Question: How would you classify this visualization?
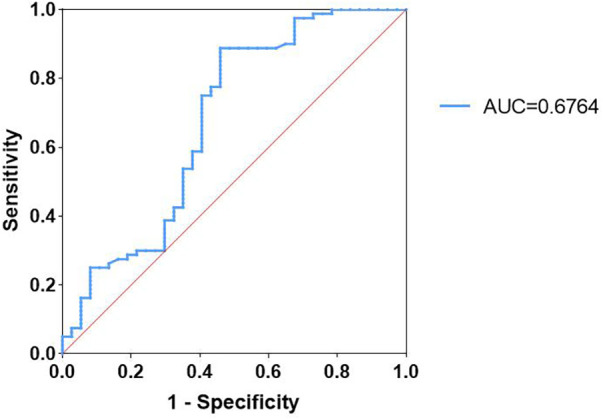
Answer: line